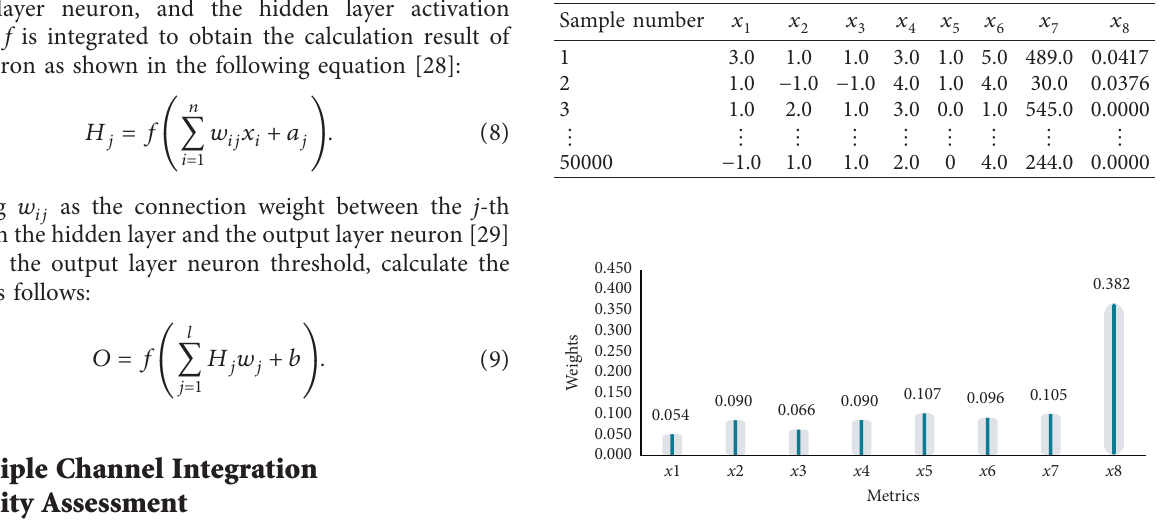
Figure 4: Evaluation index weight diagram. Table 3: Training